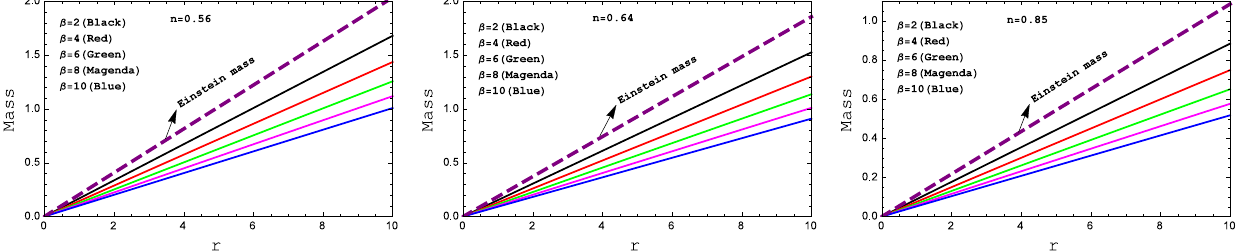
Figure 9. Behavior of the “mass profile” with respect to the radial coordinate “r” for the compact stars PSR J1614-2230 ( left panel ), Vela X-1 ( middle panel ) and 4U 1538-52 ( right panel ) corresponding to the numerical value of constants A and B from Table 2 and for different values of β .